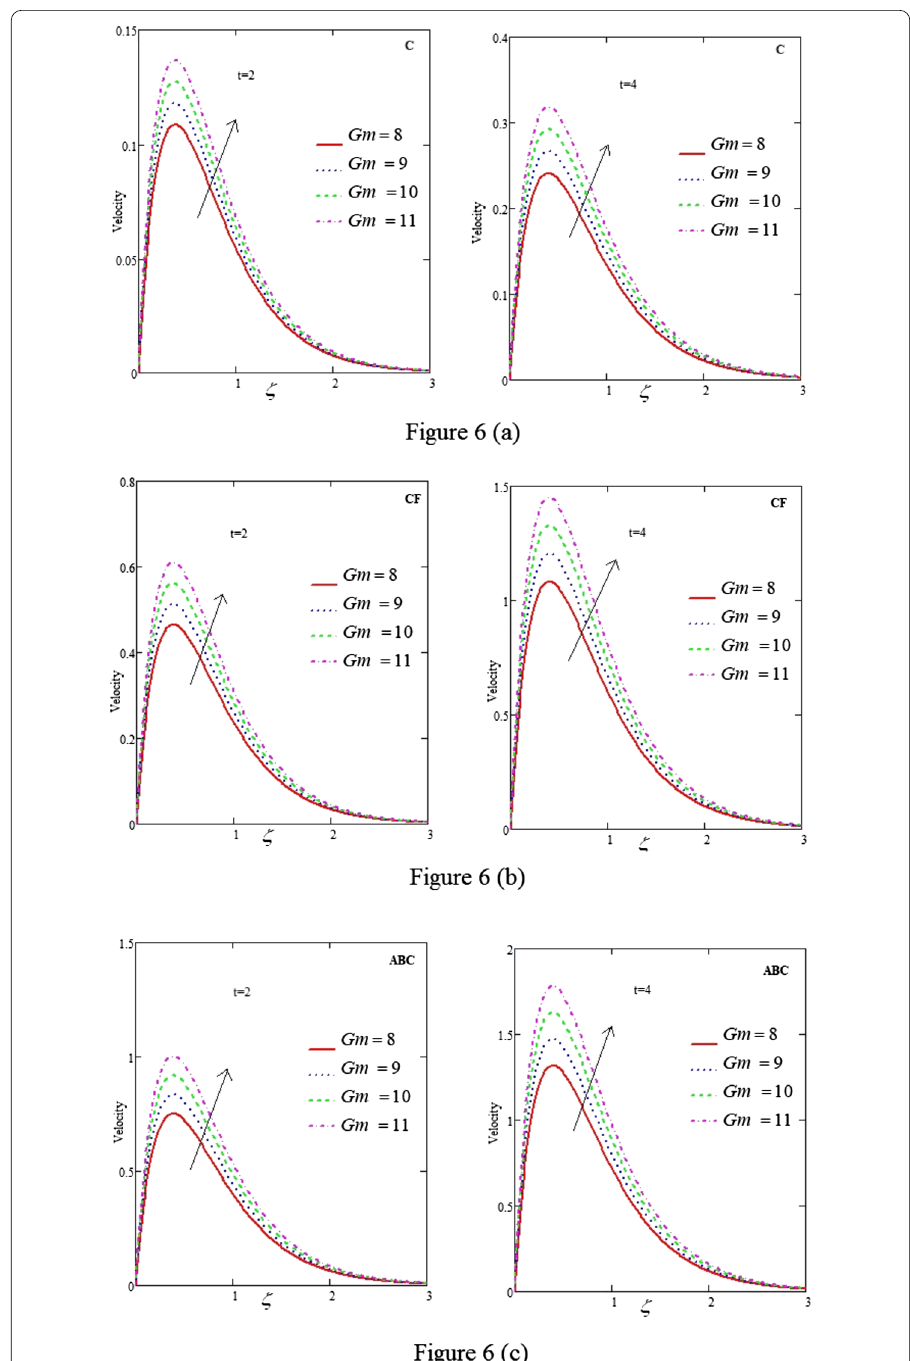
Figure 6 ( a , b , c ). Velocity curves belonging to C, CF and ABC for various values of Gm , where γ = 0.1, Pr = 6, λ = 0.2, Gr = 6, Sc = 8 and M = 4